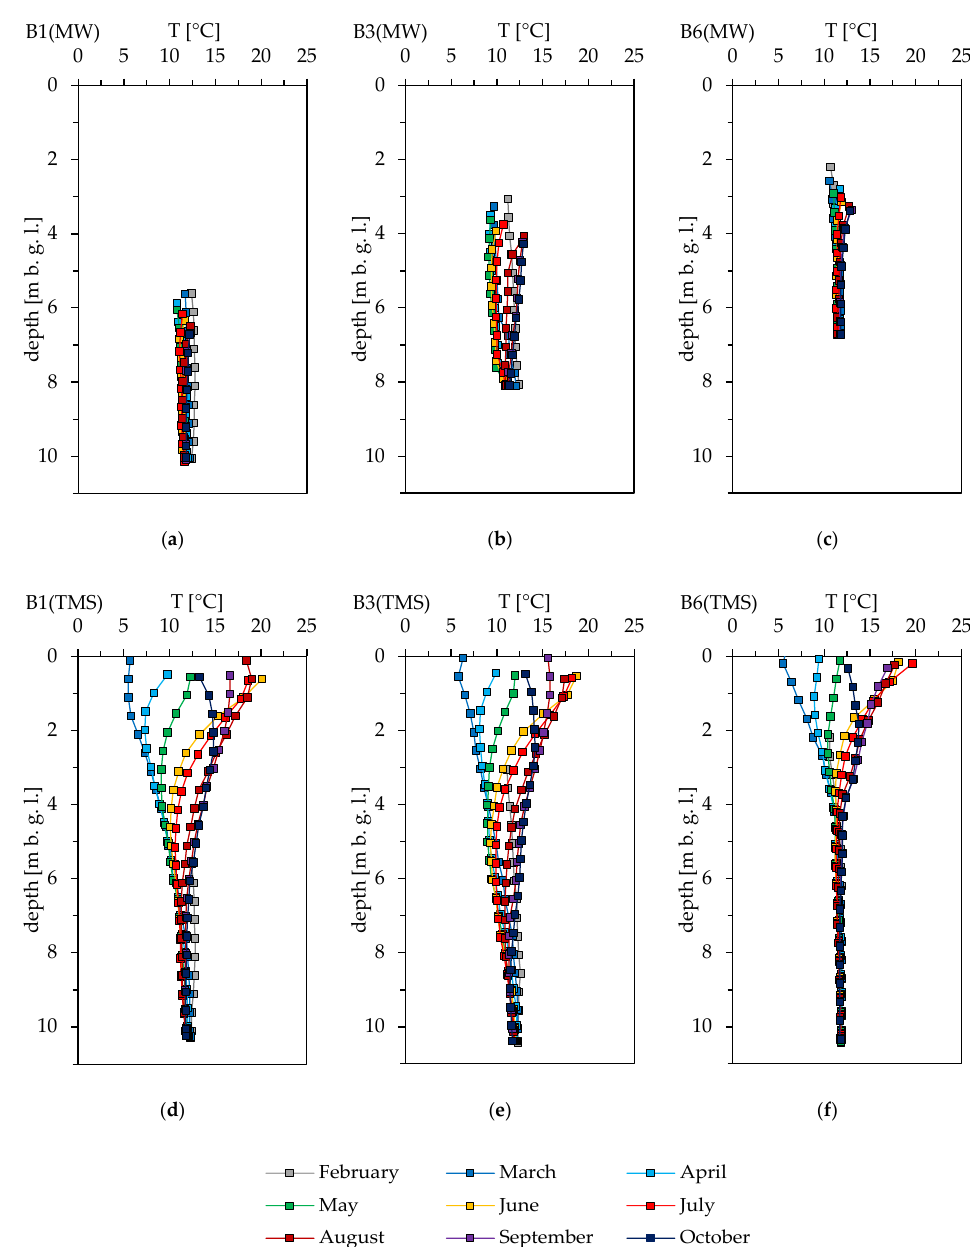
Figure 2. Examples of temperature (T) depth profiles in selected boreholes; ( a ) MW in B1; ( b ) MW in B3; ( c ) MW in B6; ( d ) TMS in B1; ( e ) TMS in B3; ( f ) TMS in B6. Temperature shifts were observed in each borehole over the nine-month measure- ment period. These shifts became more prominent with decreasing distance to ground level. As is apparent in Figure 2, the temperature shifts varied between boreholes. The temperature depth profiles recorded in the TMSs show the most significant temperature fluctuations in the first 4 m below ground level. While these fluctuations could still be observed at greater depths in other boreholes, in B6 the GWT measured in the TMS was approximately constant at depths of more than 4 m. At the bottom of the MWs in boreholes B1, B2, B4 and B5 (i.e., at a depth of approxi- mately 10 m b. g. l.), the GWT were between 10.8 °C and 12.4 °C with amplitudes of 0.8 – 1.1 K over the measuring period. Likewise, in the TMSs at depths of 10.0 – 10.4 m below